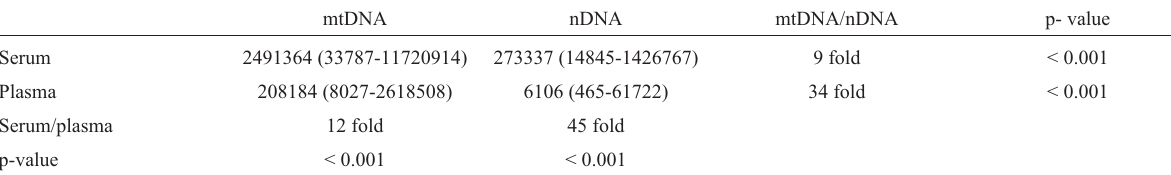
Table 1 - Ccf mtDNA and nDNA represented in genome equivalent (GE)/mL in serum and